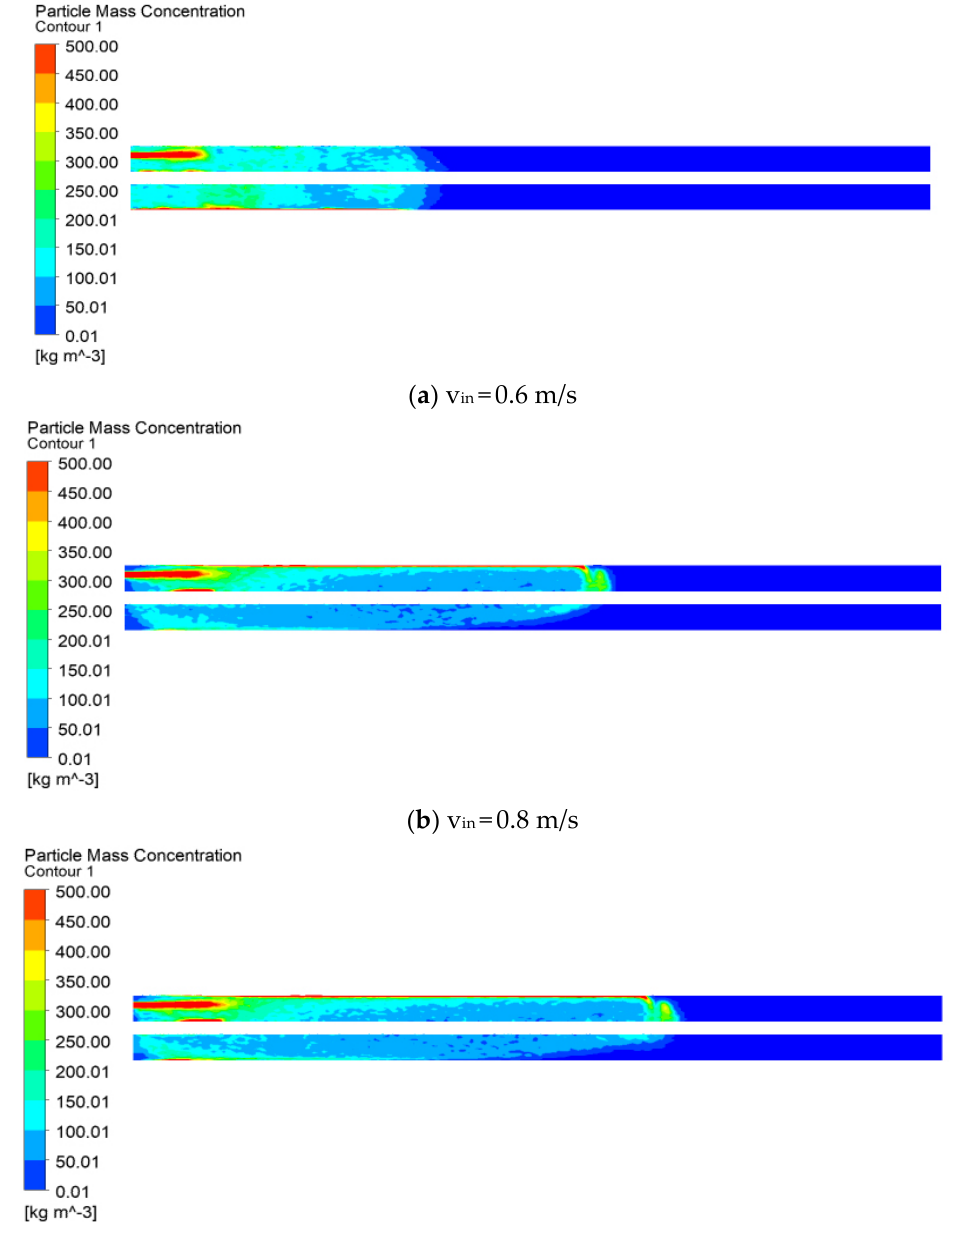
Figure 8. Contour of particle concentration in X = 0 section.